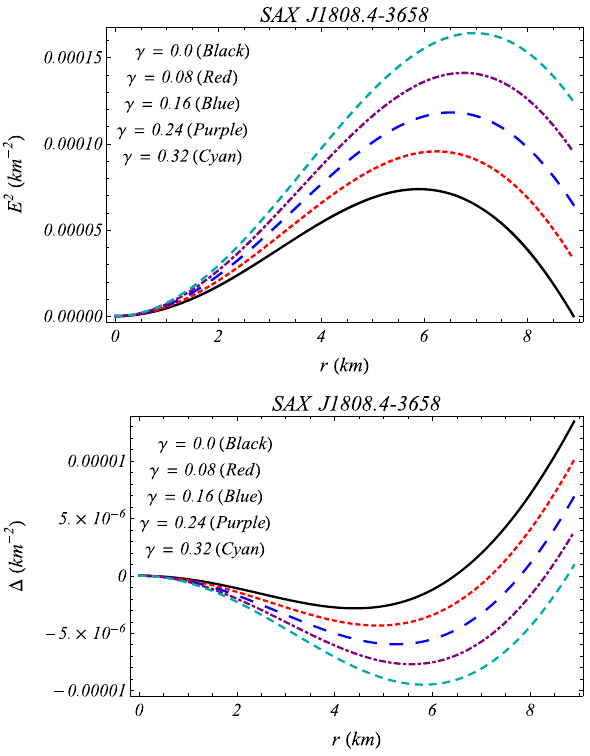
Fig. 5 (Top) E 2 and (bottom) anisotropic factor (cid:16) are shown against the radius for different values of γ mentioned in the